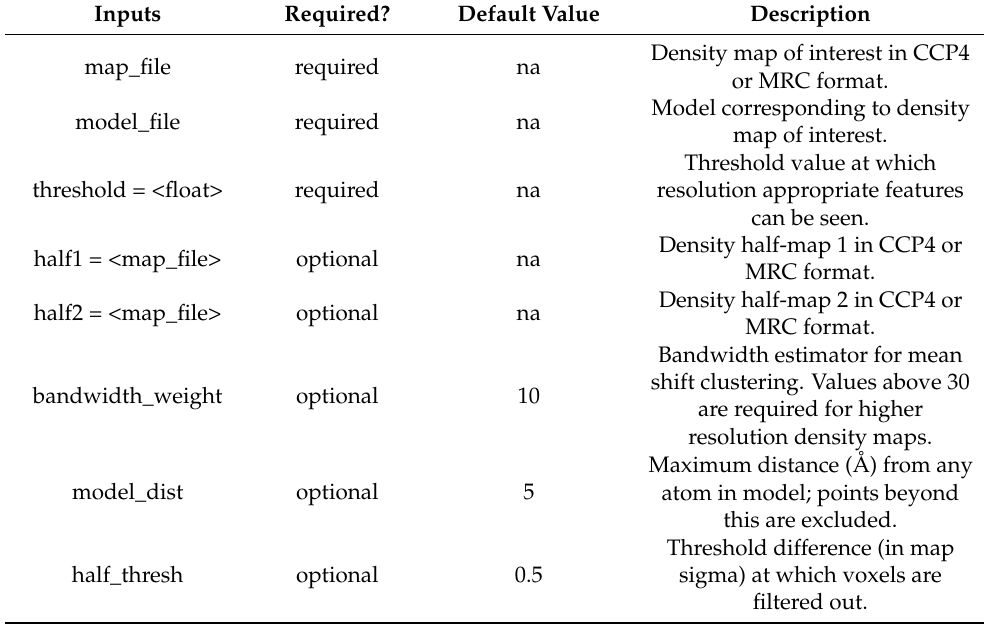
Figure 2. Ligand identification. The steps for generating a full-atom model complete with ligands using Pathwalking and pw_ligands.py is shown in order: ( A ) map filtration, ( B ) Pathwalking, ( C ) masking out of protein density, ( D ) generation of pseudoatoms (salmon) in non-protein density, ( E ) filtering pseudoatoms into putative ligands (yellow) and waters/ions (blue), ( F ) creating density masks for putative waters (purple) and ligands (yellow), ( G ) fitting ligand to density, and ( H ) refinement of ligand into density with protein components. The steps in panels ( C – F ) are automated with pw_ligands.py, while steps in panels ( A ) and ( B ) are part of Pathwalking, ligand docking ( G ) is performed in Chimera or Coot and ligand refinement ( H ) is accomplished with Phenix. Table 2. Table of pw_ligands.py option. A list of all command-line inputs, along with a description, value type and default setting is provided. Pw_ligands.py is invoked using python pw_ligands.py <map file> <threshold> <nres => <options>.